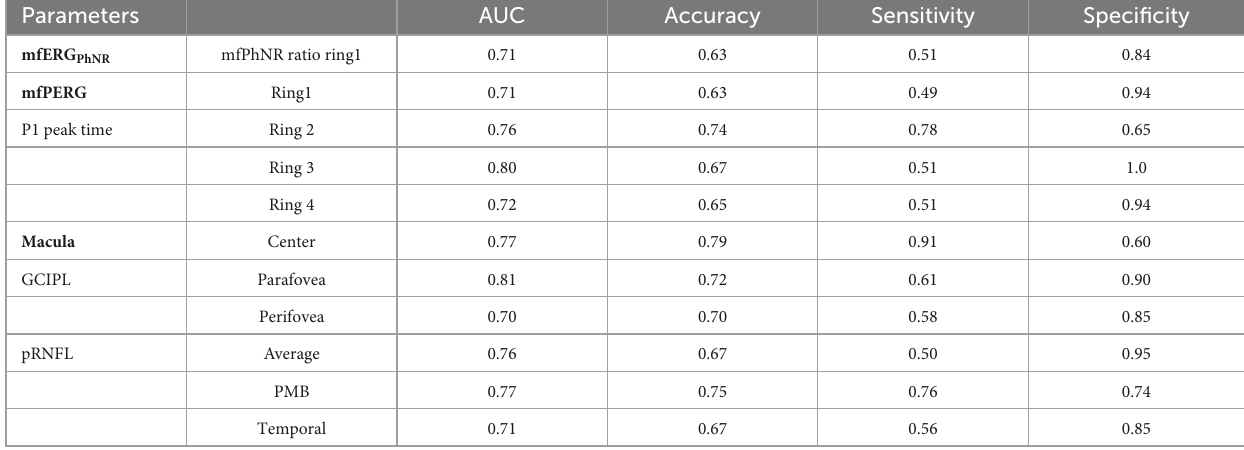
TABLE 4 Diagnostic performance of functional and structural